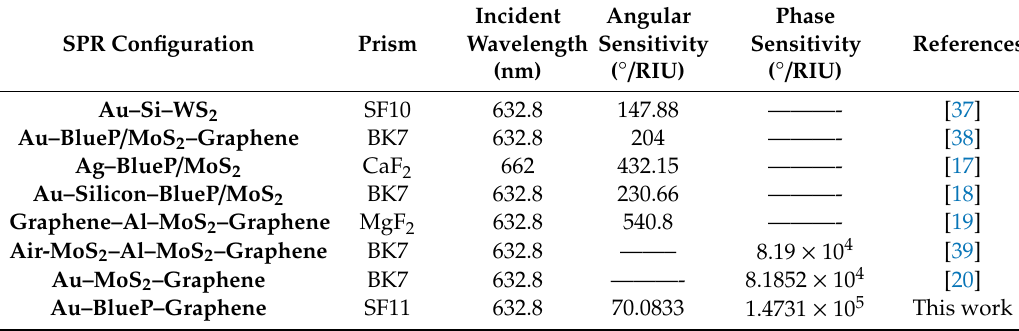
Figure 8. For an extremely tiny refractive index variation in a level of 1 × 10 − 6 RIU, the comparison of change in di ff erential phase with regard to the pure 42 nm Au film, 42 nm Au film / 4-layer graphene, and 42 nm Au film / 2-layer BlueP / 4-layer graphene. Annotation: Au (42 nm)_BlueP (2L)_G(4L) in Figure 8 is the abbreviation of our proposed configuration (42 nm Au film / 2-layer BlueP / 4-layer graphene. Table 2. Comparison of detection sensitivity calculated by angular or phase modulation based on previously reported